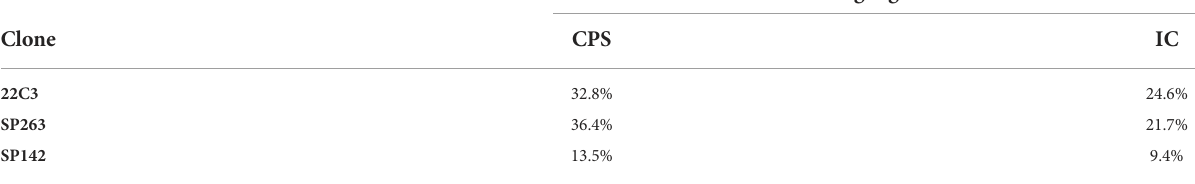
Scoring algorithm